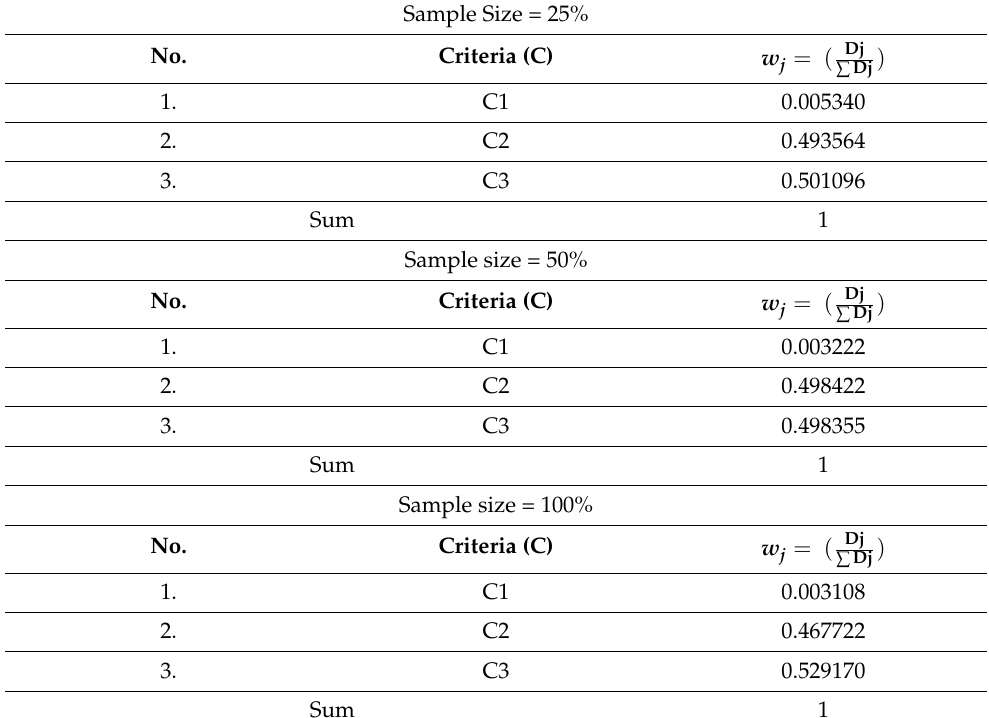
Table 10. Criteria weights for each data